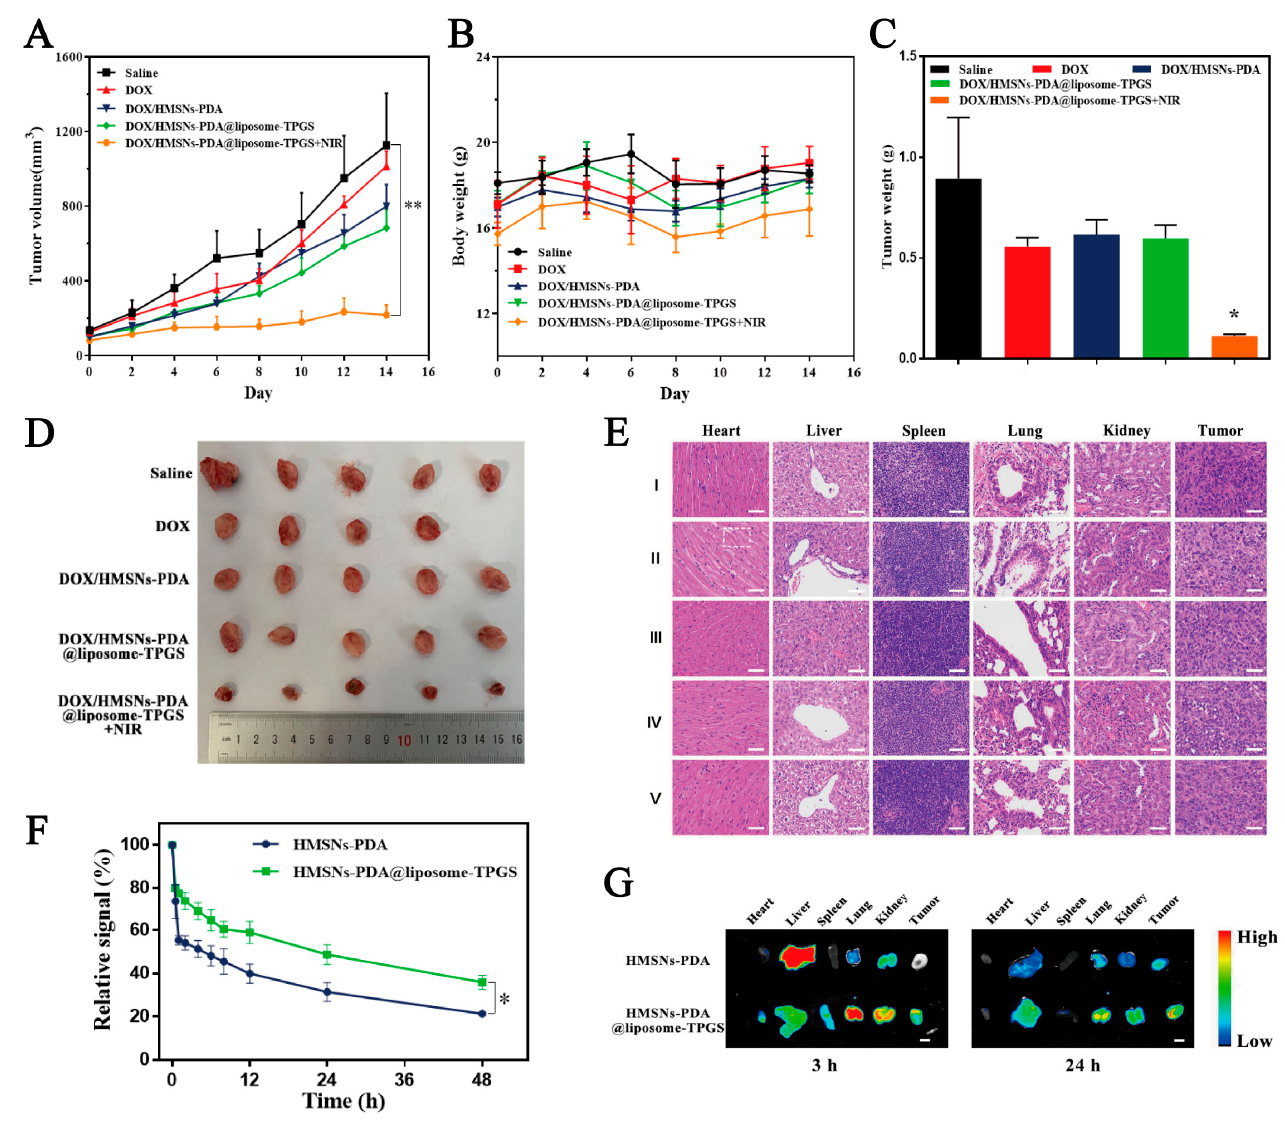
Figure 5. ( A ) Tumor volume changes in 4T1 tumor-bearing mice treated with saline, DOX, DOX/HMSNs-PDA, DOX/HMSNs-PDA@liposome-TPGS, and DOX/HMSNs-PDA@liposome-TPGS + NIR for 14 days (n = 5). Note: ** p < 0.01. ( B ) Relative body weight of 4T1 tumor-bearing mice treated with different samples for 14 days (n = 5). Tumor weight of tumor-bearing mice ( C ) and picture of tumors excised from mice ( D ) treated with different preparations for 14 days (n = 5). Note: * p < 0.05 vs. saline group. ( E ) HE staining photographs from different treatment groups. Scale bar: